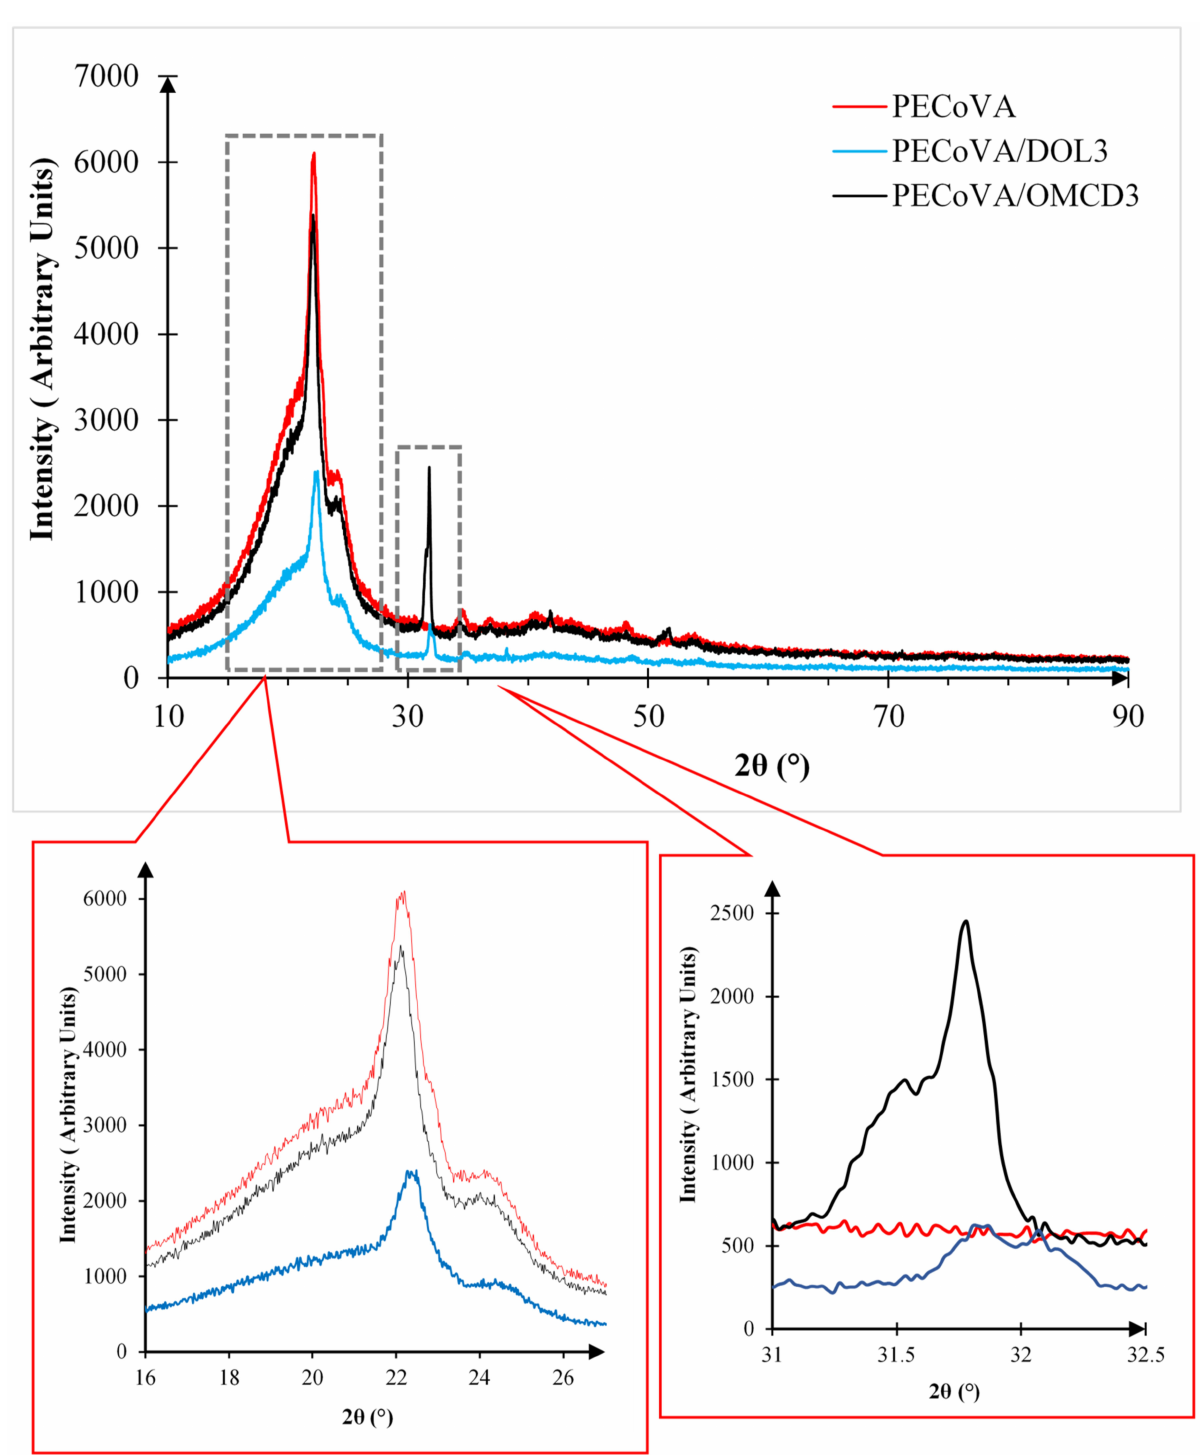
Figure 5. X-ray diffraction (XRD) pattern of PECoVA composites with different type of